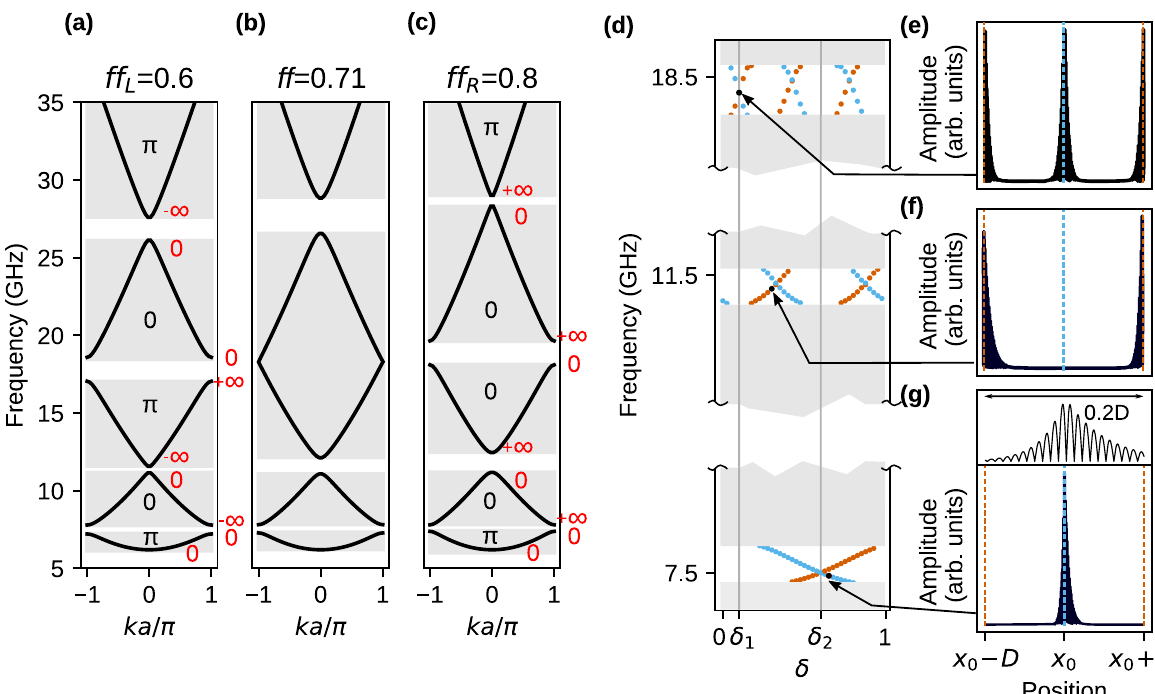
Figure 4. ( a – c ) Closing and reopening of the frequency gap (above the 1st band, at the edge of 1st Brillouin π/ a ) with the changes of filling fraction ff for exchange waves. The successive dispersion relations zone: k = ± 0.6 , ( b ) just closed, ff 0.71 , and ( c ) opened again, ff R 0.8 . were plotted when the gap is ( a ) opened, ff L = = = The values 0 and π are the Zak phases of the bands, 0 and (red color) stand for logarithmic derivative on the ∞ δ 1 edges of band gaps. The values of Zak phases and logarithmic derivatives were determined for the case δ = (i.e., for Co strip in the center of the unit cell). The SW interface modes localized on the interface of two MCs of 0.6 and ff R 0.8 . ( d ) The SW spectrum in the function of the surface parameter δ , defining the selection ff L = = of the unit cells for 1D MC on the right. ( e – g ) The profiles of the SW interface modes in the gaps above 1st, 2nd and 3rd bands. We use the same conventions to mark the frequencies and localization of the SW interface modes as in Fig. 3e, f. Inset above ( g ) presents a close-up of the SW profile near the interface. It can be seen that despite the fact of decaying, the character of the mode is